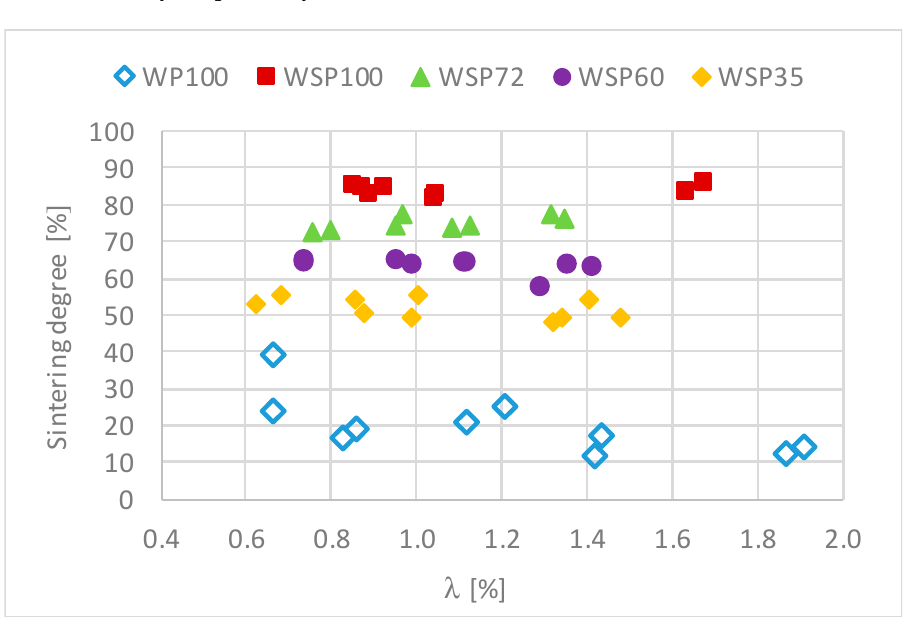
Figure 7. Sintering degree versus λ for the WP100 and MSP family. For WP100, the sintering degree decreases with λ (r = − 0.67, p = 0.032) because the combustion temperature decreases also (see Figure 5). It should be noted that the values are significantly higher in tests with lower λ , which is consistent with the strangely high temperatures obtained in these tests. Agropellets present a significantly higher sintering degree than WP100, even with small percentages of herbaceous (MSP10), in line with the lower values of ash fusibility temperatures presented by these fuels (see Table 2). Further- more, it was not possible to find a correlation between the sintering degree and λ . Due to tests being performed with λ values greater and less than 1, the temperature variation was small, especially for MSP family tests (see Figure 5 or Table 3), which caused a lesser sin- tering degree variation than what had been detected in similar experiences with blended pellets [44]. Regarding the bottom ash proportion with respect to the total amount of ash fed with the fuel, Figures 8 and 9 show the relationship of this parameter with λ for the WP100 and for each of the two fuel families (WSP family and MSP family). WP100 has a lower bottom